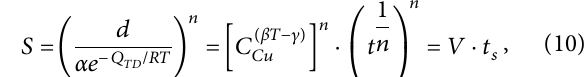
Figure 4: The relationships between d and t . (a) C T � 150 °